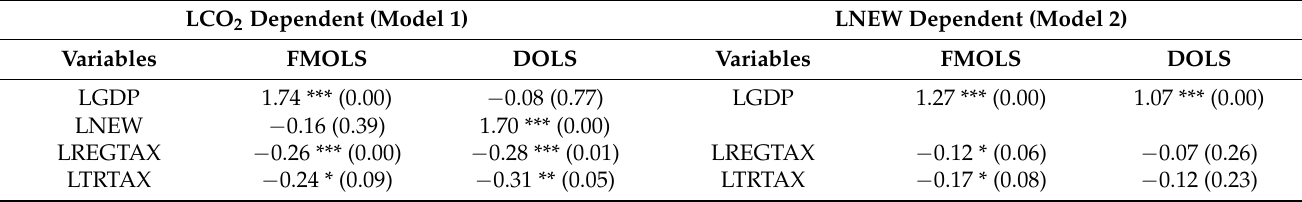
Table 5. Panel Fully Modified Least Squares Model and Dynamic Ordinary Least Squares Estimator Results. LCO 2 Dependent (Model